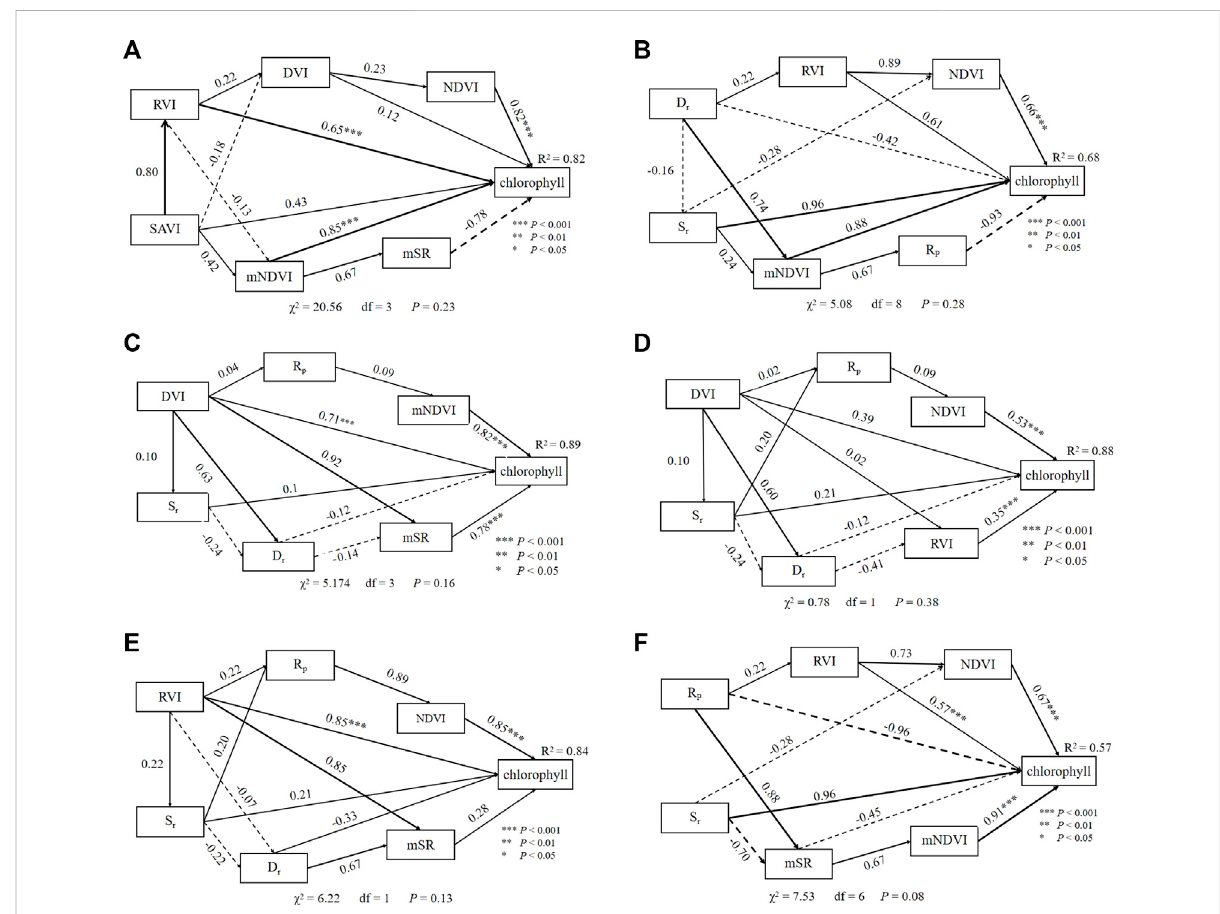
Analysis of the relationship between the chlorophyll content and the NDVI, RVI, DVI, mSR, mNDVI, SAVI, red-edge amplitude, red-edge area, and red-edge position using the structural equation model. The solid and dotted lines represent positive and negative coef fi cients, respectively. The thickness of the arrows indicates the size of the standardized path coef fi cient. R 2 represents the proportion of variance interpretation of each endogenousvariable. (A) isthescreeningvegetationindex, (B) isthehigh correlation vegetation index with rededge parameter, (C) , (D) , (E) and (F) are to verify the correlation between vegetation index and red edge